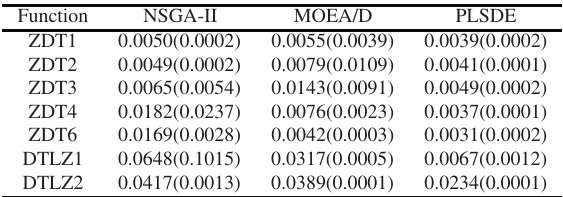
Table 2. IGD metric values of the solutions obtained by NSGA- II, MOEA/D and PLSDE